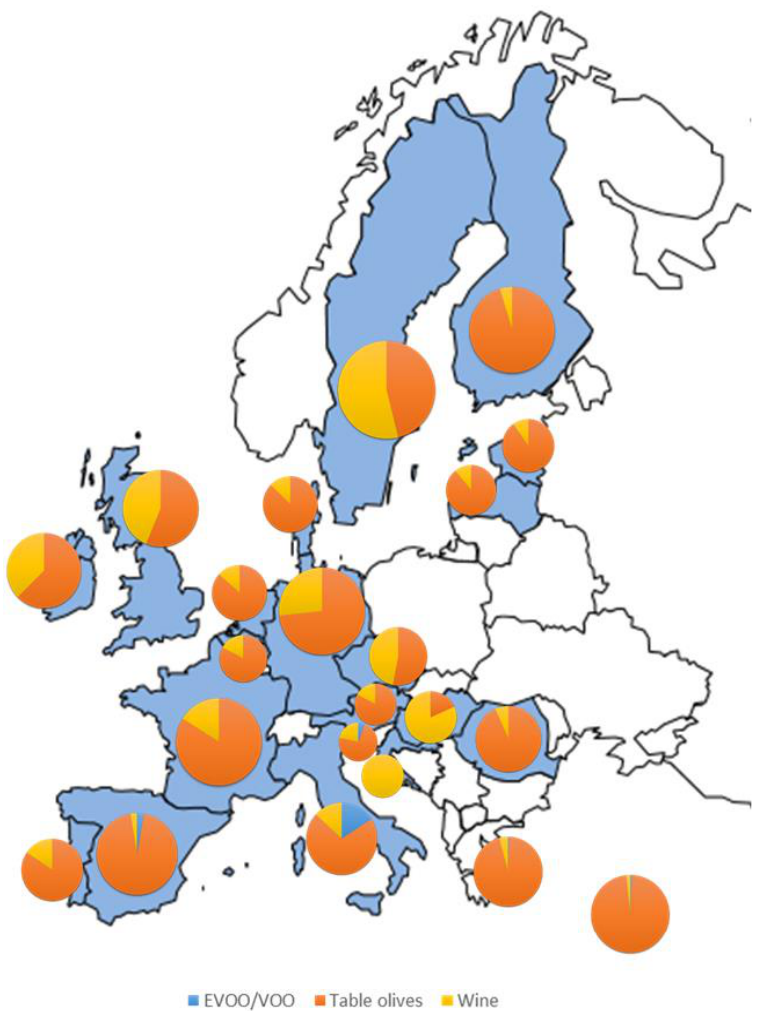
Figure 5. Relative contribution of EVOO/VOO, olives, and wine to free HT dietary intake in the European adult population by country (percentage %).